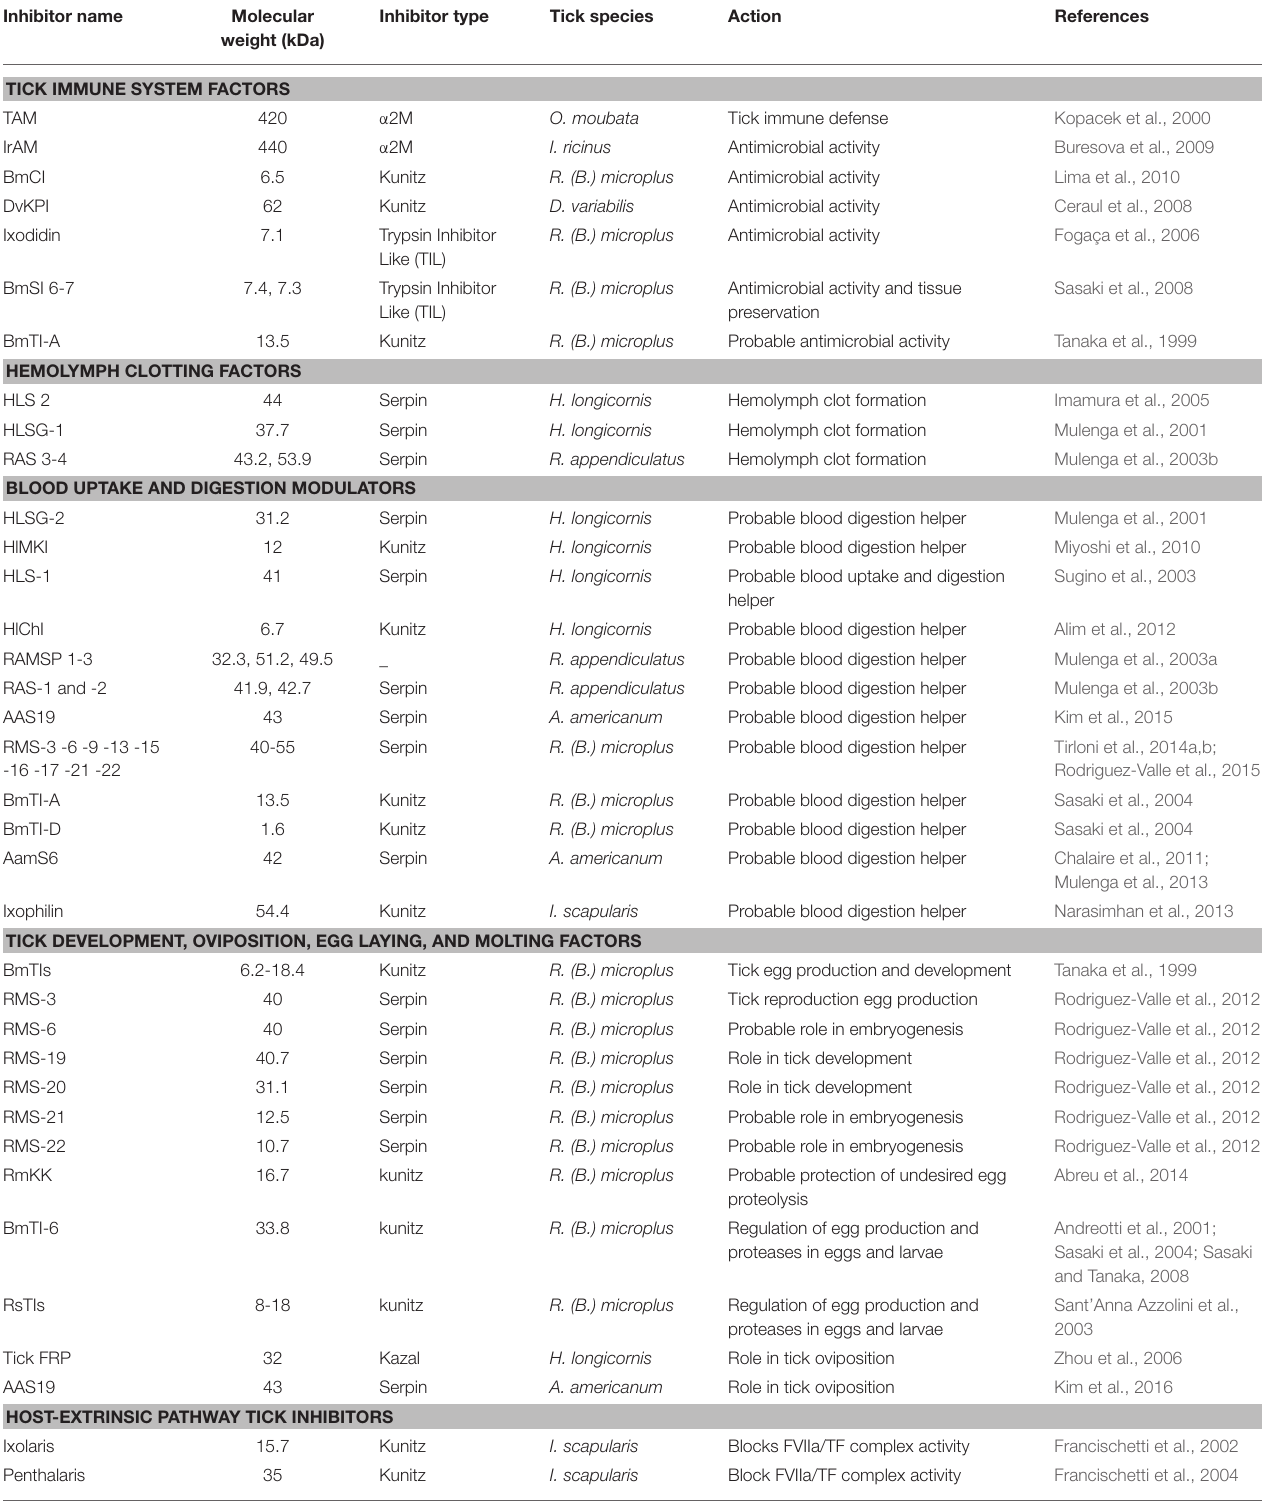
TABLE 1 | Tick serine protease inhibitors implicated in both tick biology/physiology and modulation of vertebrate host responses to tick bite, classified according to their inhibitor group (Serpin, Macroglobuline, Kunitz, Kazal), and the corresponding tick